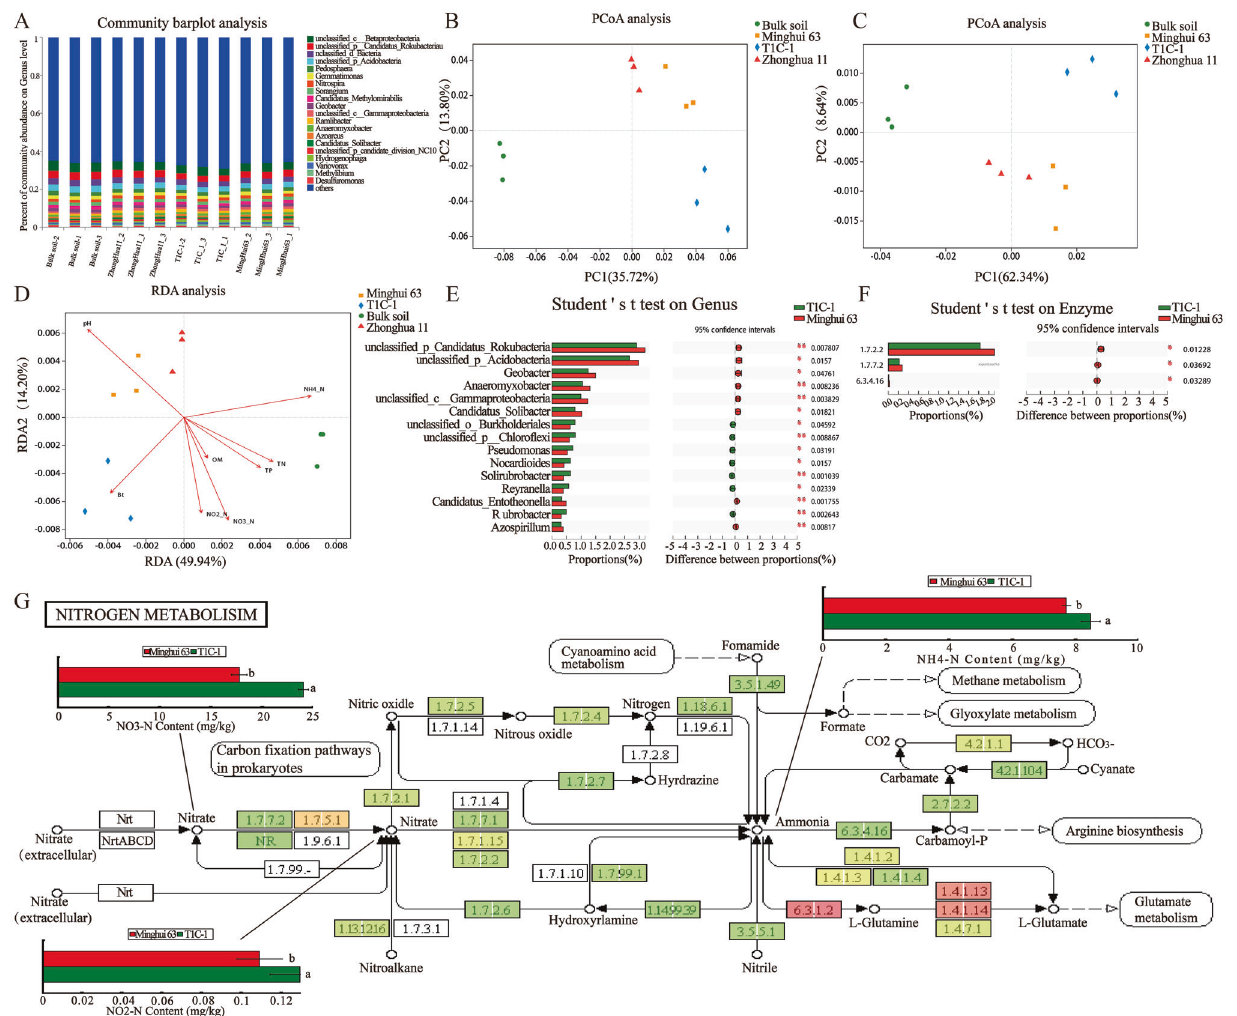
Fig. 4 Variation in the soil microbes and their function in nitrogen-transforming. A Relative abundances of major microbial genera in soil samples. Principal coordinates analysis (PCoA) based on microbial genus level ( B ) and COG (Clusters of Orthologous Groups) function ( C ) pro fi les of samples. D RDA of soil physico-chemical properties and microbial community compositions at the genus level. Microbial genera ( E ) and enzymes ( F ) that signi fi cantly differed between T1C-1 and Minghui 63 rhizosphere metagenomes. G Metabolic pathways identi fi ed in this study as important distinguishing features based on rhizosphere metagenomic analysis comparison between T1C-1 and Minghui 63 soils. The box in the fi gure represents a pair of samples, and the depth of color represents the change of enzyme abundance among different samples. Enzyme Commission (EC) Numbers can be inquired in the website: